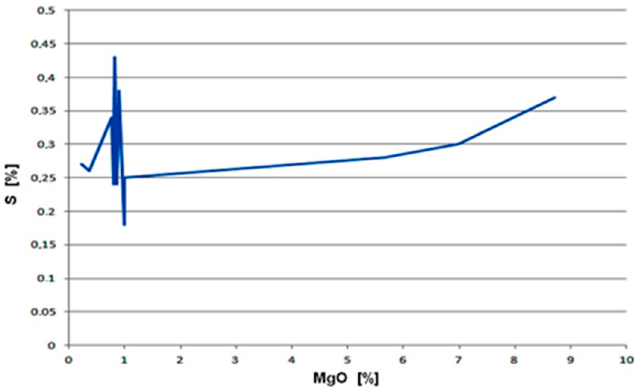
Figure 16. The amount of absorbed SO 2 (%) of the post-reaction product by carbonate sorbent samples with varied content of the MgO (%) [21]. Red line—the trend line of the probable increase.